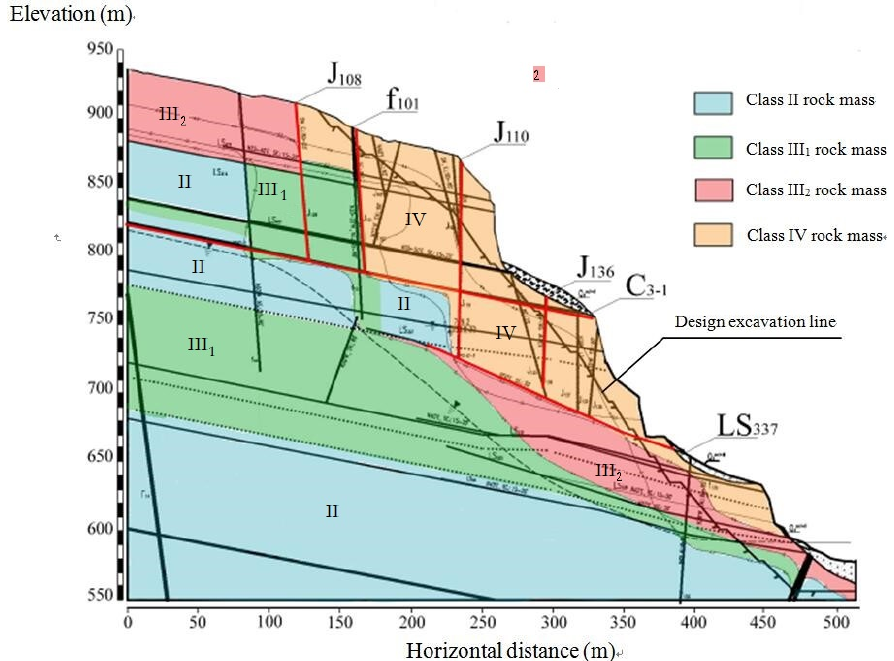
Figure 6. Simulation range and geological structure of the I 5 section. Table 1. Physical–mechanical parameters of the structural planes.